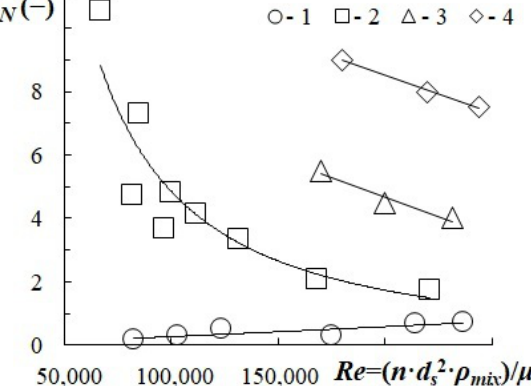
Figure 14. Dependence of the power criterion on the Reynolds number for the stirrer h = 0.05 (m), at a temperature of 13–60 ◦ C, n = 600–2400 (rpm), H L / D = 1.2, d s = 0.064 (m) with a variation in the number of partitions: 1—without partition; 2—one partition; 3—two partitions; 4—three partitions.